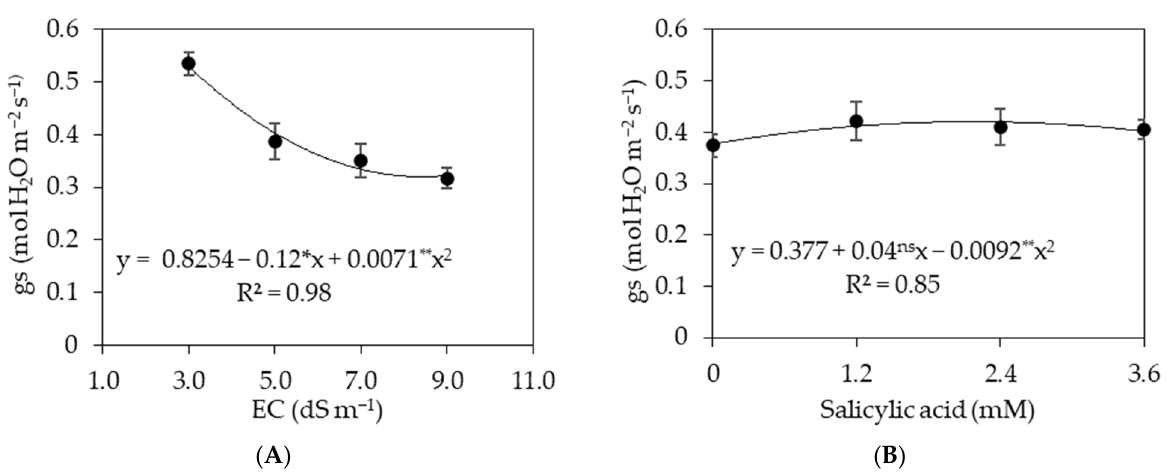
Figure 11. Stomatal conductance— gs of ‘Canindé’ okra cultivated in a hydroponic system as a function of the electrical conductivity of the nutrient solution—EC ( A ) and salicylic acid concentrations ( B ) 60 days after transplanting. * and ** Significant at p ≤ 0.05 and ≤ 0.01, respectively. The vertical lines represent mean +/ − standard error (n = 4).